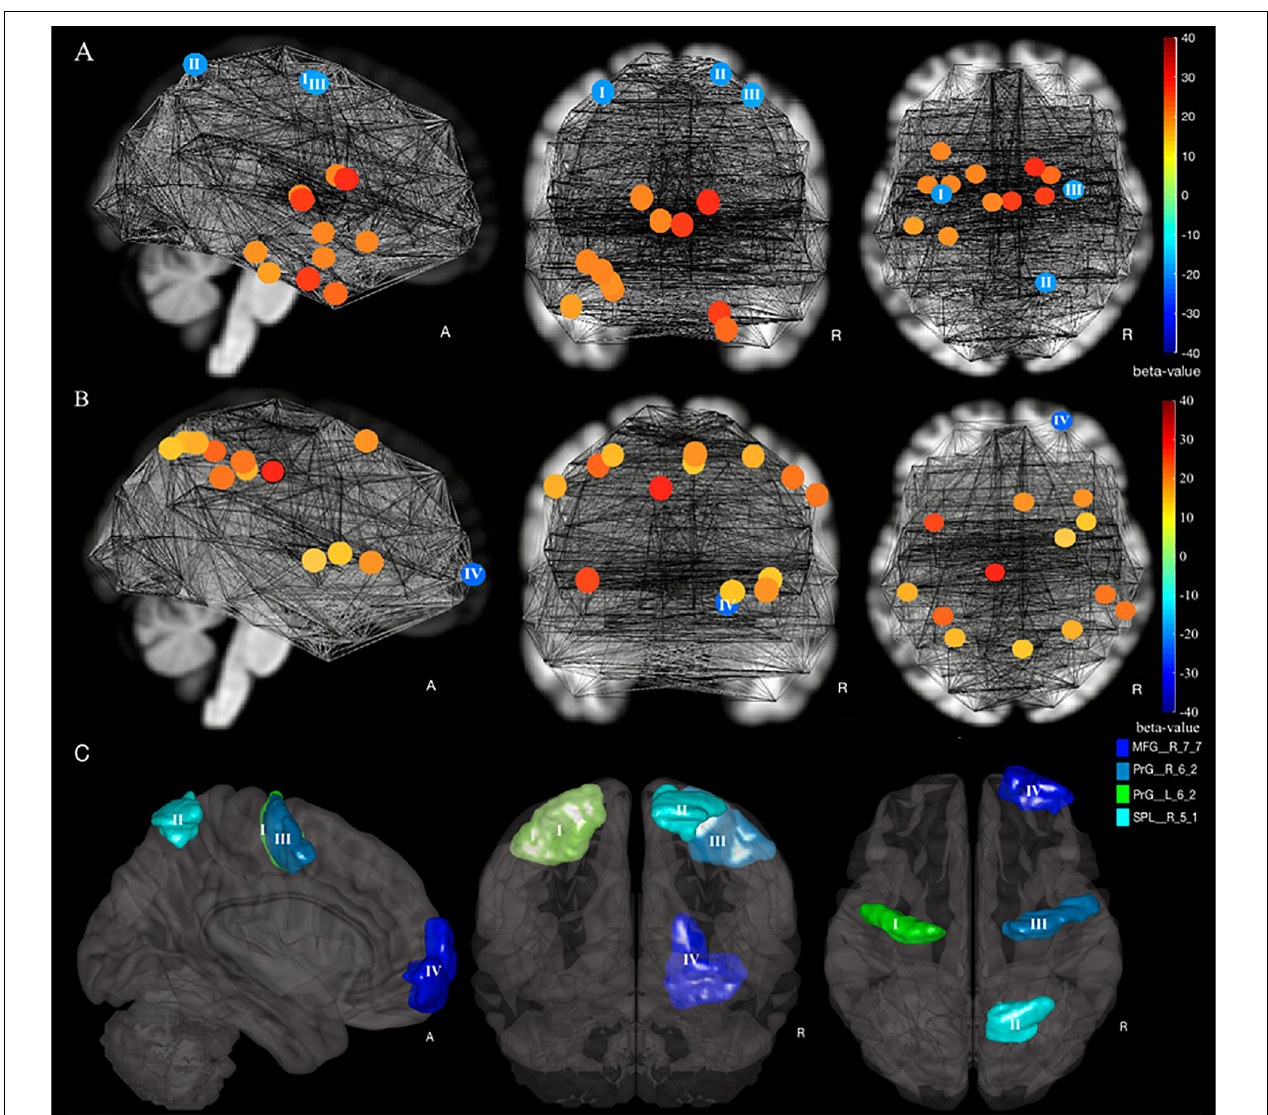
FIGURE 2 | Increase and decrease of degree centrality in a comparison of young HC, senior HC, and MCI. (A) Young HC vs. senior HC and MCI contrast, in which blue shade circles represent a significant increase, and red shade circles represent a significant decrease of DC in Senior HC and MCI subjects compared to young HC ( p < 0.05, FDR-corrected). (B) Senior HC vs. MCI contrast, in which blue shade circles represent a significant increase, and red shade circles represent a significant decrease of DC in MCI subjects compared to senior HC ( p < 0.05, FDR-corrected). The significant ROIs are according to labeling by the